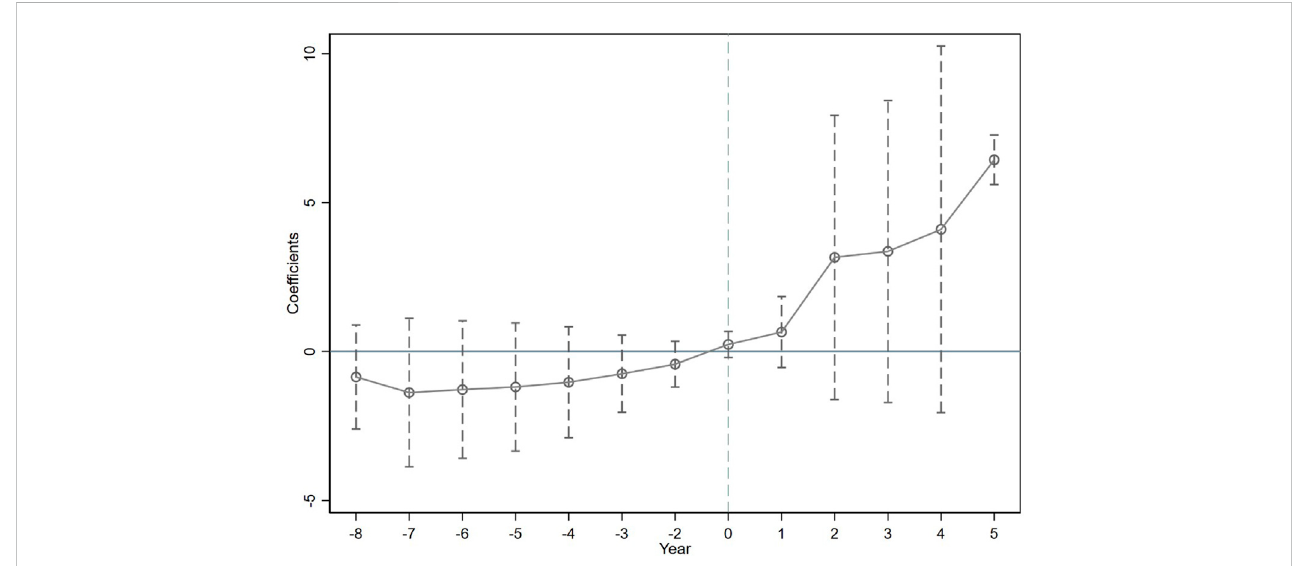
FIGURE 2 Parallel trend of total carbon emissions. Notes: Circles indicate the coef fi cients, and solid lines indicate 95% con fi dence